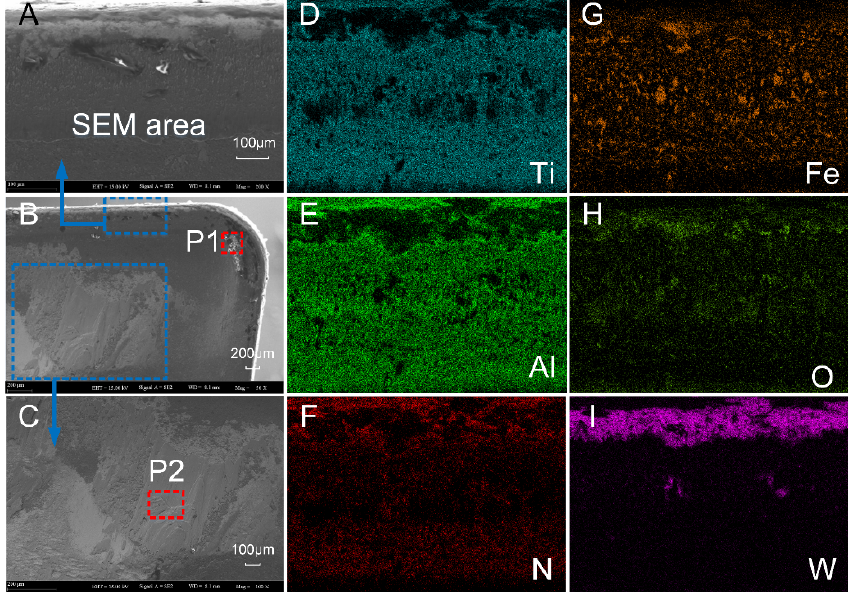
Figure 13. ( A – C ) The rake face wear of Tool B after 110 min of cutting. ( D – I ) Distribution of major elements.